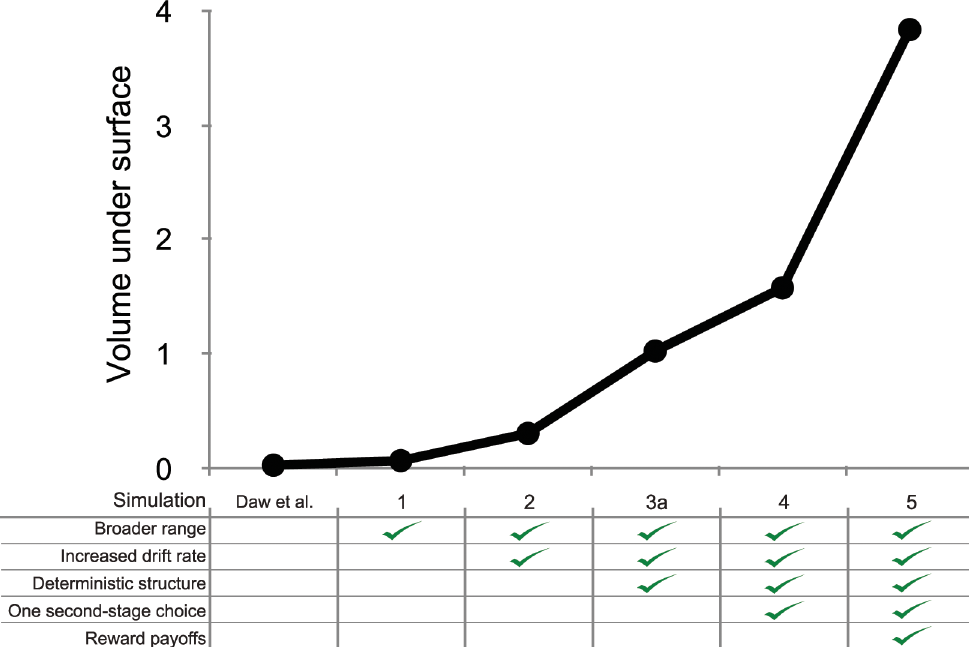
Fig 13. Comparison of trade-off between model-based control and reward across different paradigms. We calculated the volume under the surface of coefficients of the linear relationship between the weighting parameter and the reward rate for each of the paradigms in the section above. Across these simulations, we progressively included elements that strengthened the relationship, as summarized in this